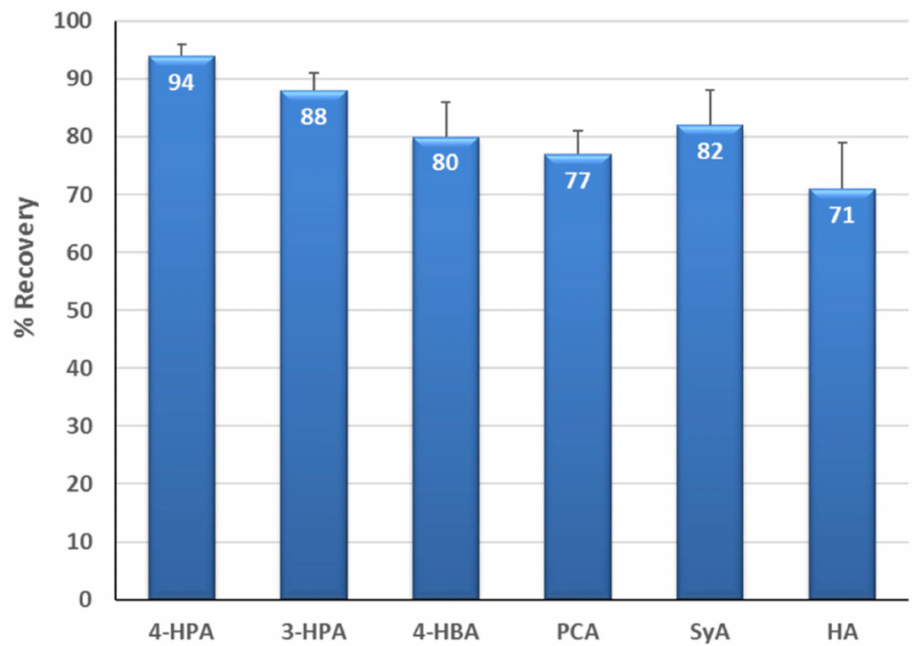
Figure 5. Recoveries percentage of the phenolic acid analogues obtained from the MISPE procedure. In the urine sample, the concentration of each phenolic acid was 4 mg/L. Error bars indicate the standard deviation of replicates ( n = 3).